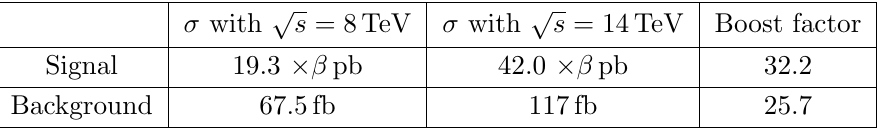
p s =14TeV) (cid:2) L 14TeV , where L 14TeV is assumed to p (cid:27) ( s =8TeV) (cid:2) L 8TeV